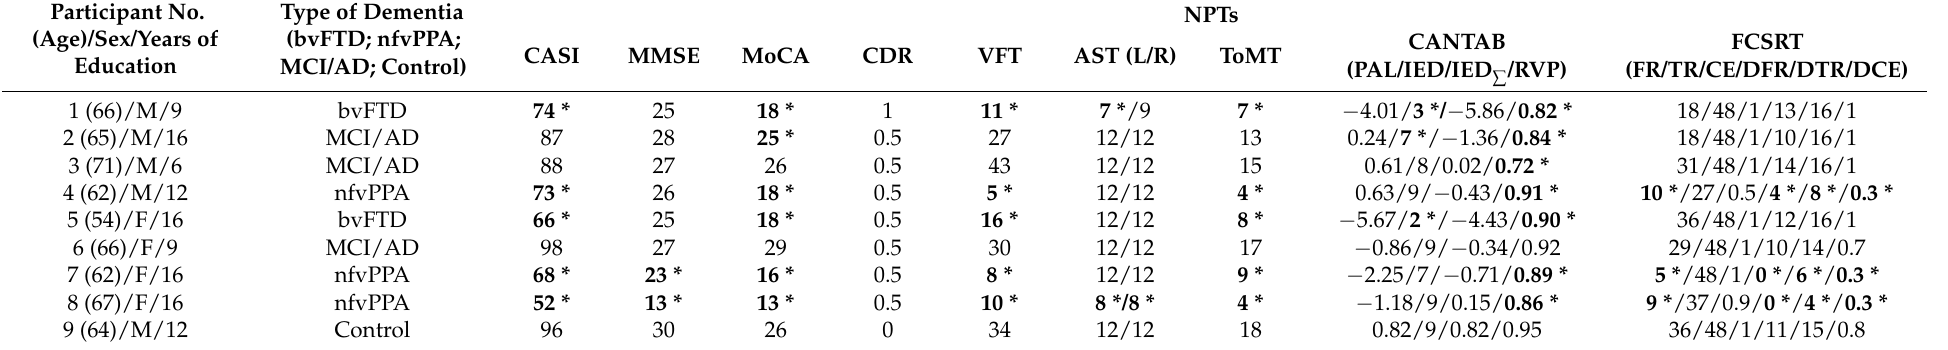
CASI—the Cognitive Abilities Screening Instruments; MMSE—the Mini-Mental State Examination; MoCA—the Montreal Cognitive Assessment; CDR—the Clinical Dementia Rating; CANTAB—the Cambridge Neuropsychological Test Automated Battery; VFT—the Verbal Fluency Test; AST—the Apraxia Screening Test; ToMT—the theory of mind test; FCSRT—the Free and Cued Selective Reminding Test; FTLD—the frontotemporal lobar degeneration; AD—Alzheimer’s disease; SPECT—single-photon emission computed tomography; MRI—magnetic resonance imaging; MCI/AD—Early stage of Alzheimer’s disease; bvFTD—behavioral variants of frontotemporal dementia; nfvPPA—nonfluent nonfluent/agrammatic variant of primary progressive aphasia; and Superscript “*” stands for cognitive